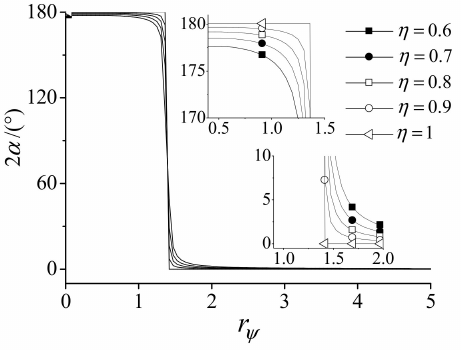
Figure 10. Stable phase differences of two-thirds of ERs using control synchronization.